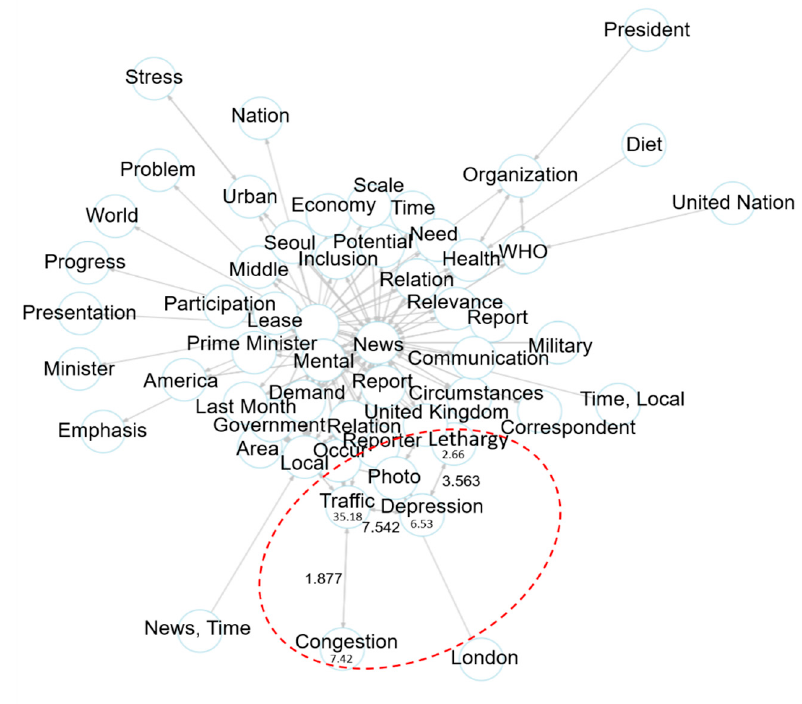
Figure 9. Optimized Associative Knowledge Graph based on Figure 9. O ptimized Associative Knowledge Graph based on TF-IDF.